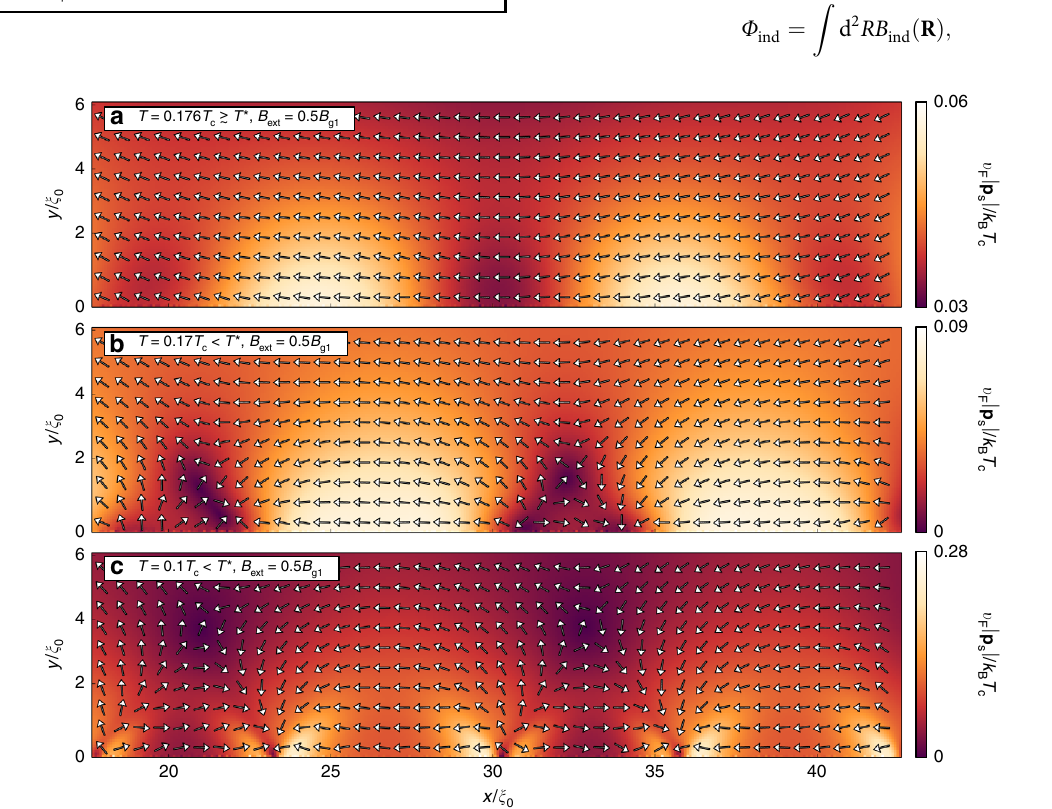
The fi eld scale B g1 = Φ 0 / A corresponds to an external magnetic fl ux through the grain area exactly equal to one fl ux